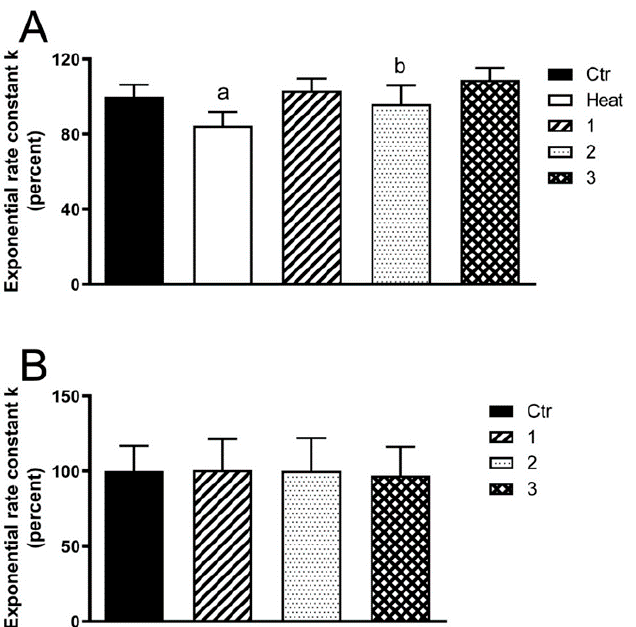
Figure 5. Effect of compounds 1 – 3 on the water permeability of HeLa cells in heat-stress condition ( A ) and in normal non-stressed condition ( B ). ( A ) Comparison between untreated cells (Controls, Ctr), cells treated at 42 ◦ C for 3 h (heat-stressed, Heat), heat-stressed cells pre-treated with test compounds at 20 µ M final concentration. ( B ) Effect of the compounds on water permeability of HeLa cells incubated at 21 ◦ C for 3 h. Controls (Ctr) indicate cells incubated without compounds. Bars represent the osmotic water permeability of HeLa cells expressed as percent of the exponential rate constant k. Values are means ± SD of 4–15 single shots (time course curves) for each of 4–6 different experiments. a, p < 0.01 vs. Ctr, 1 , 2 , 3 ; b, p < 0.05 vs. 3 (Repeated measures ANOVA, followed by Newman-Keuls’s Q